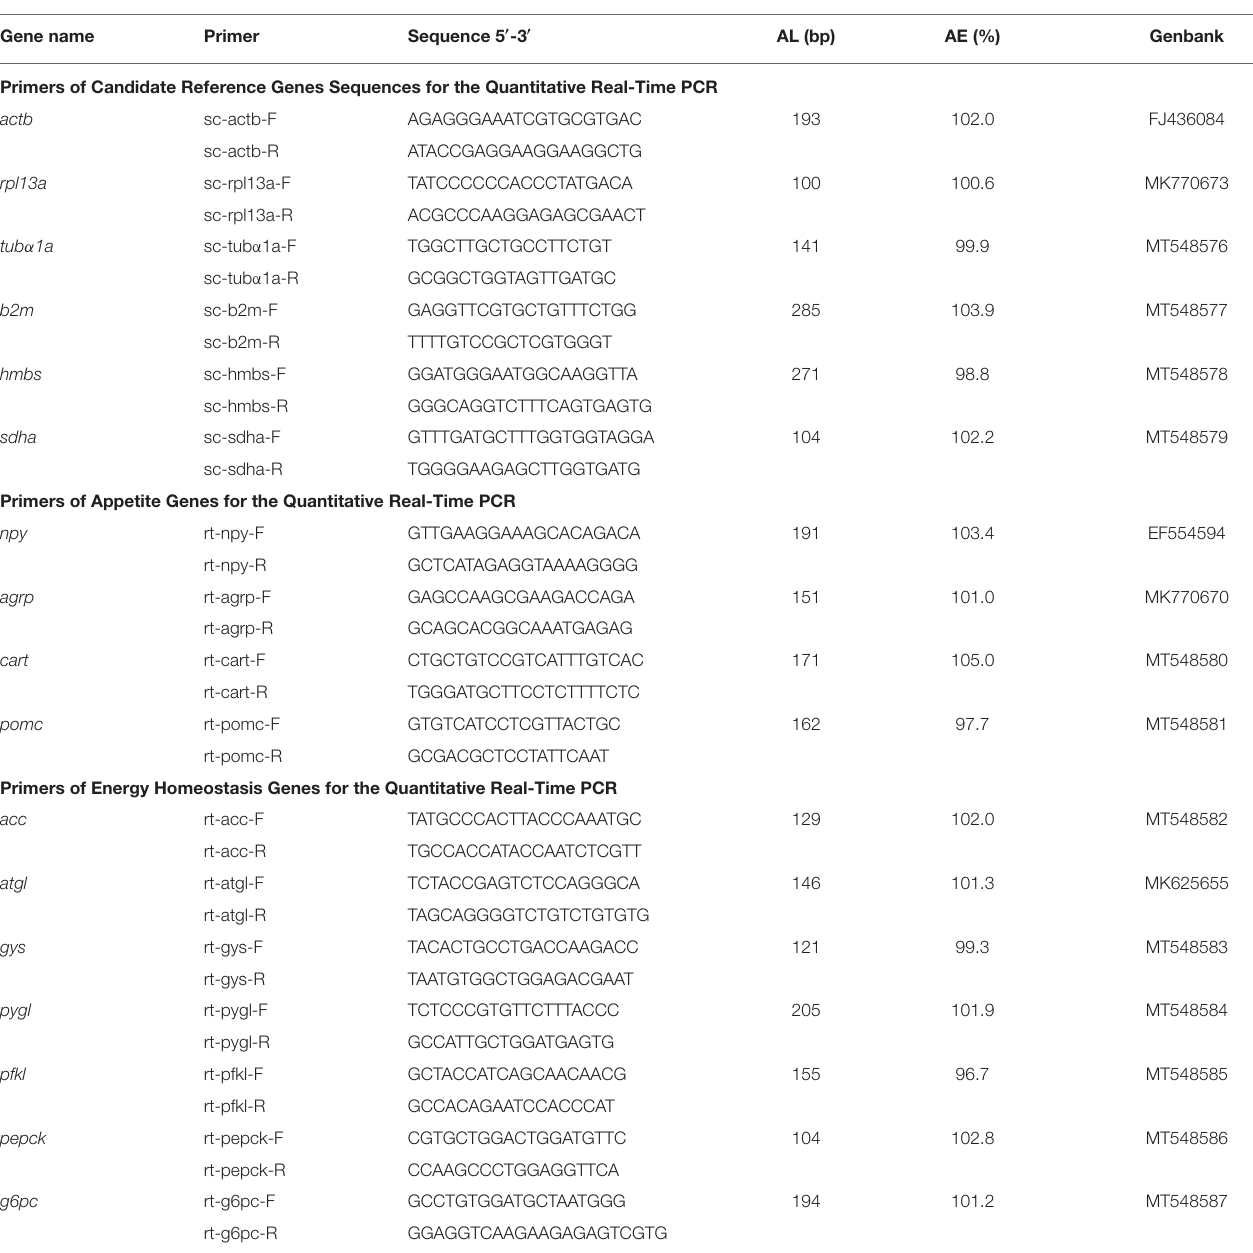
TABLE 2 | Primer sequences for gene